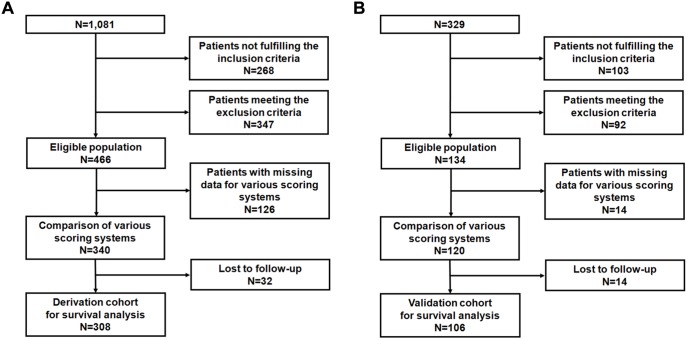
Flow charts for the derivation cohort (A) and the validation cohort (B).